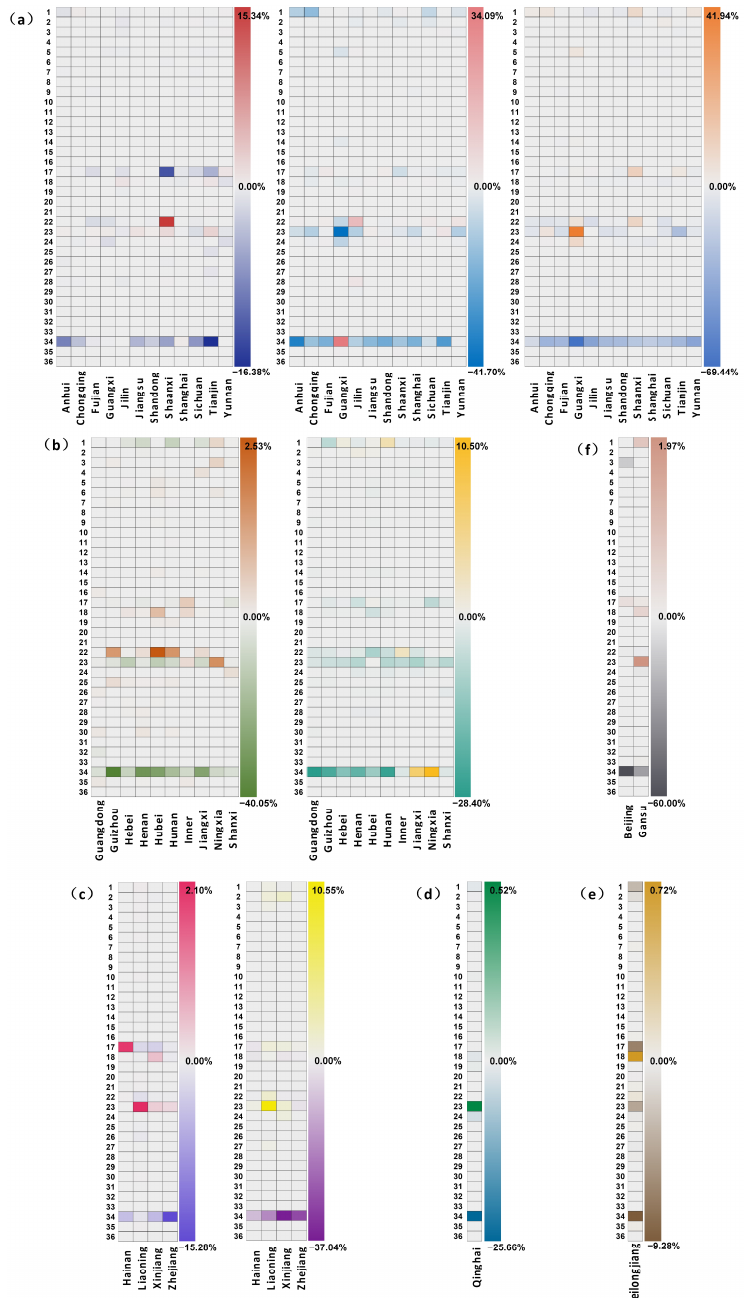
2 Figure 2. Attribution of CO 2 mitigation to the industrial sectors through energy structure, industrial structure, and energy intensity. ( a ) Group 1 (the inhibitive factors are energy structure, industrial structure, and energy intensity). ( b ) Group 2 (the inhibitive factors are industrial structure and energy intensity). ( c ) Group 3 (the inhibitive factors are energy structure and energy intensity). ( d ) Group 4 (the inhibitive factor is energy structure). ( e ) Group 5 (the inhibitive factor is industrial structure). ( f ) Group 6 (the inhibitive factor is energy